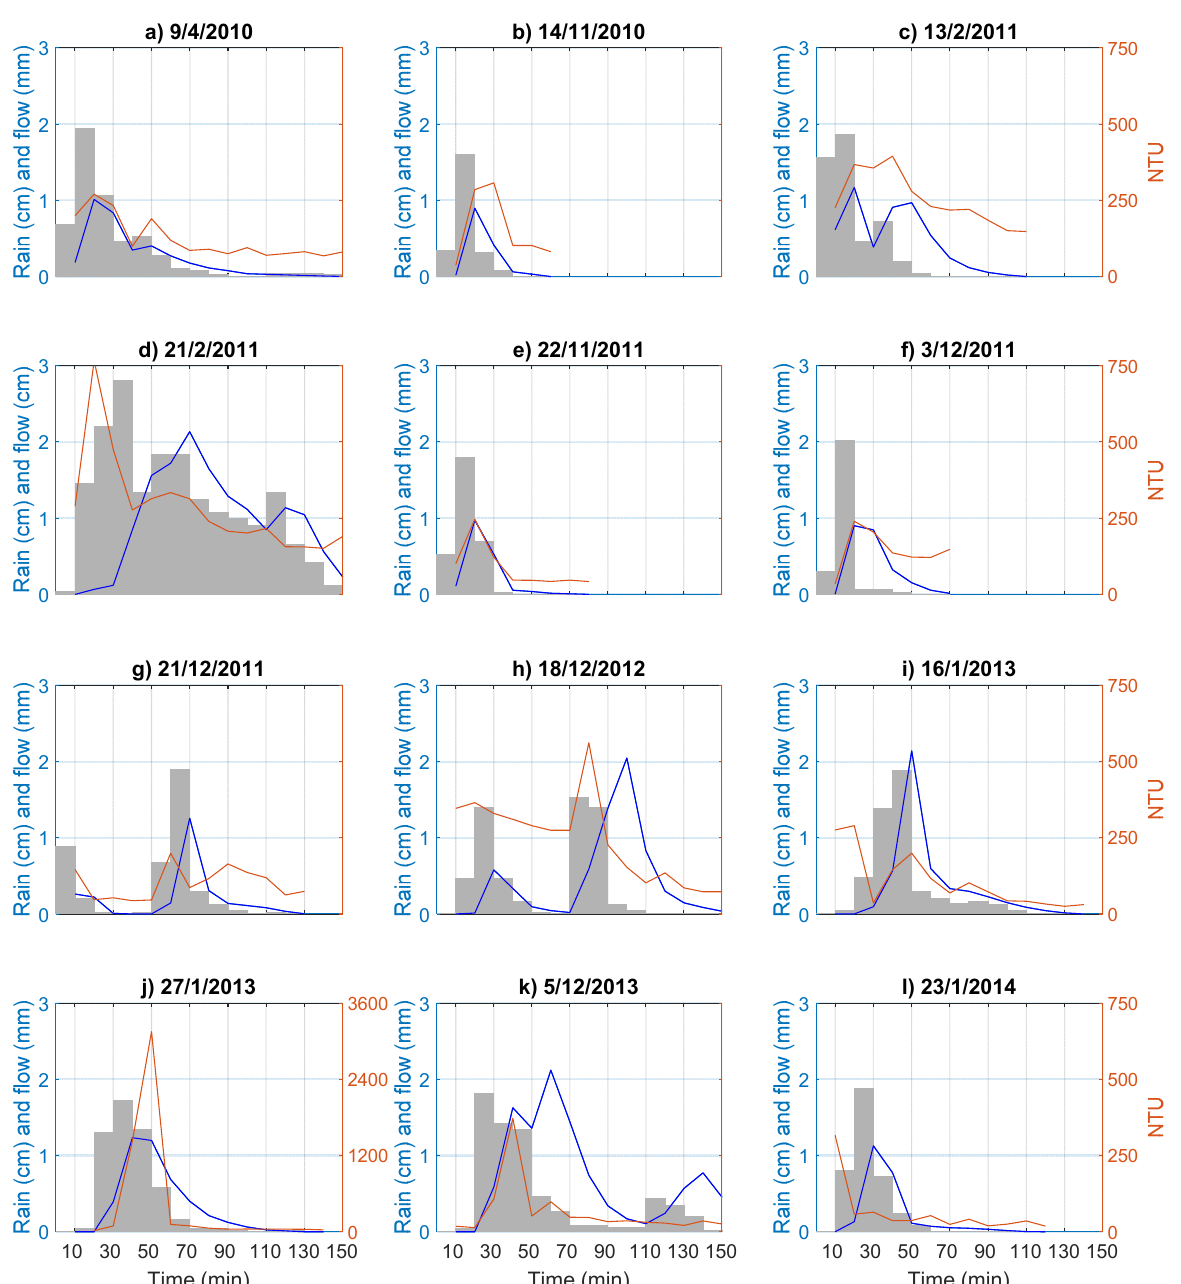
Figure 8. Rainfall–runoff–turbidity dynamics for the 12 largest events in terms of the rainfall volumes with complete turbidity data. The grey bars represent rainfall (cm per 10 min interval), the blue lines signify the runoff (mm per 10 min interval) and the brown lines represent the turbidity (NTU). A common x -axis scale of 0 to 150 min was used to ease the comparison, although some events ceased prior to 150 min. A common y -axis scale of 0 to 750 NTU was used, except for ( j ), which has a greater NTU range. The runoff in ( d ) was exceptionally large and thus it is presented in units of centimetres instead of millimetres.